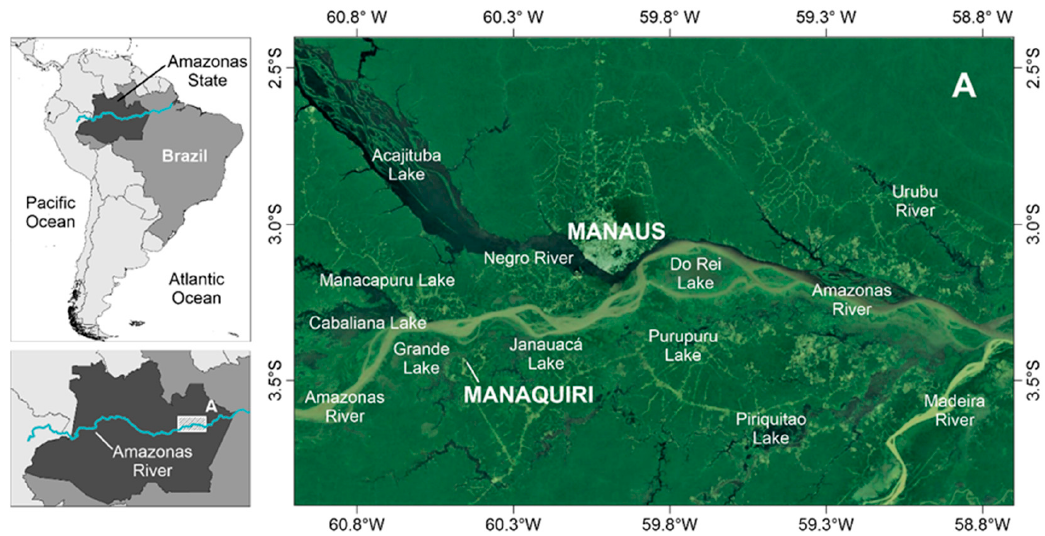
Figure 3. Example of the complexity of the fluvial system around the municipalities of Manaus and Manaquiri, Amazonas State, Brazil. Adapted from Google Maps.